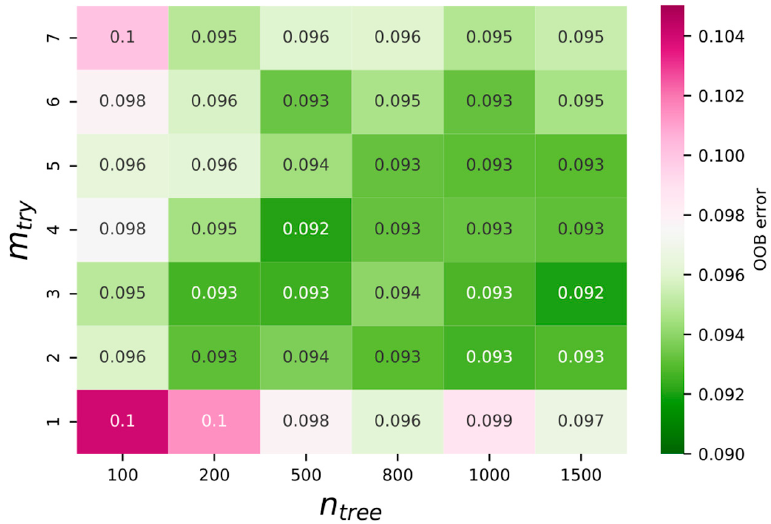
Figure 5. The OOB error as a function of the number of predictors (m try ) and the number of trees (n tree ).